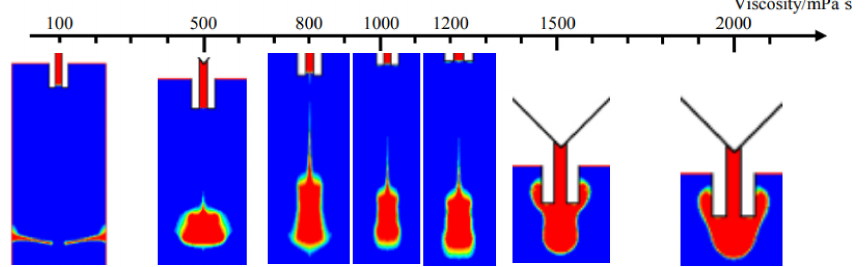
Figure 5. Simulation results from changes in viscosity.